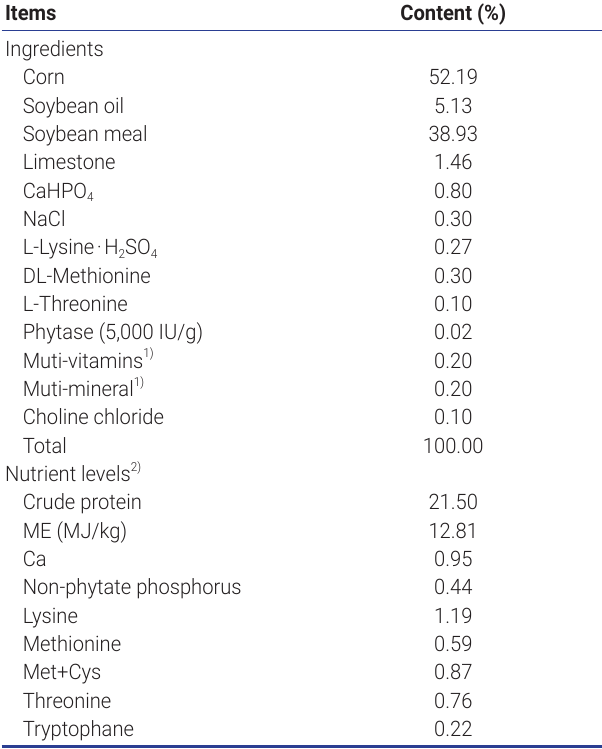
Table 1. Composition and nutrient levels of the basal diet (air-dry ba- sis %)